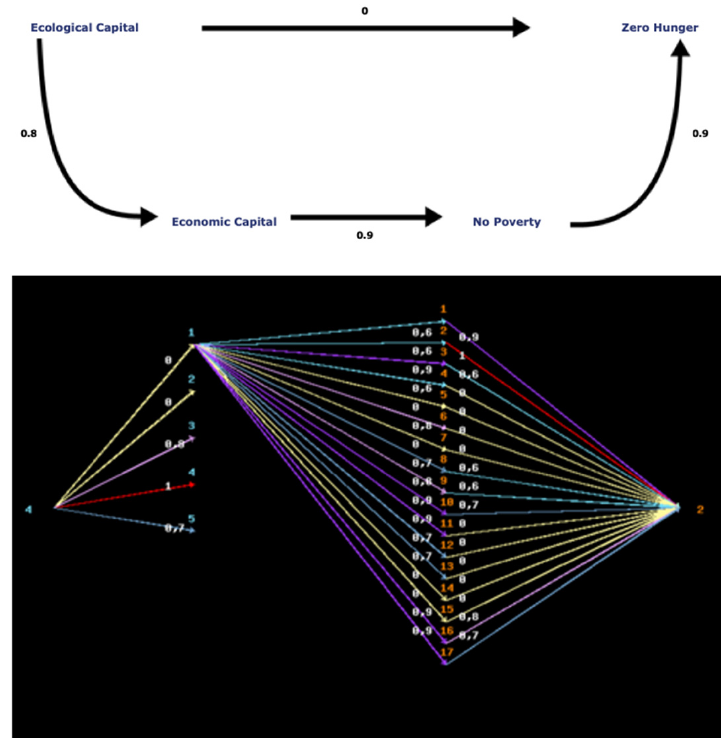
Figure 13. Relation between Ecological Capital (H4) and Zero Hunger (SDG2).